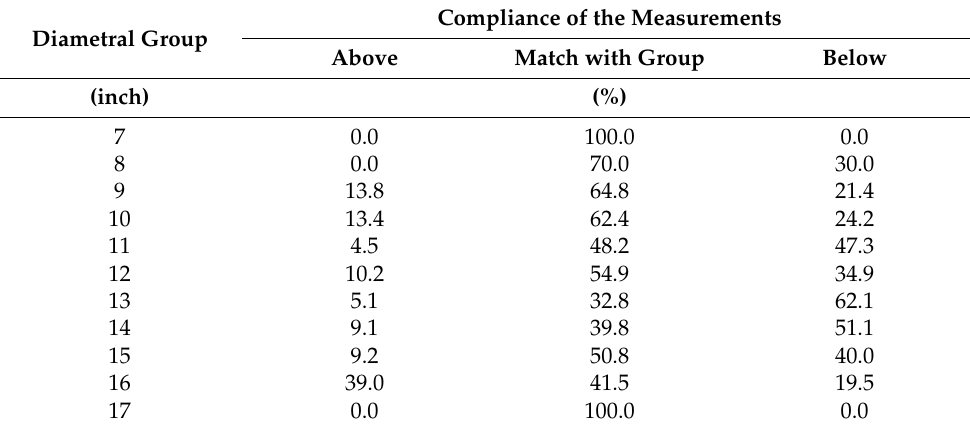
Table 2. The compliance between the automatic sorting results and the manual measurements. Compliance of the Measurements Diametral Group Above Match with